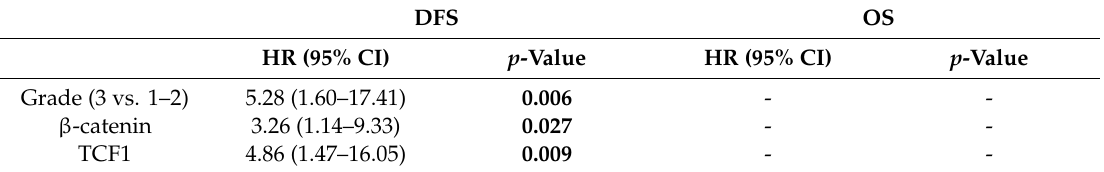
Table 4. Multivariate analysis of DFS (disease-free survival) and OS (overall survival).